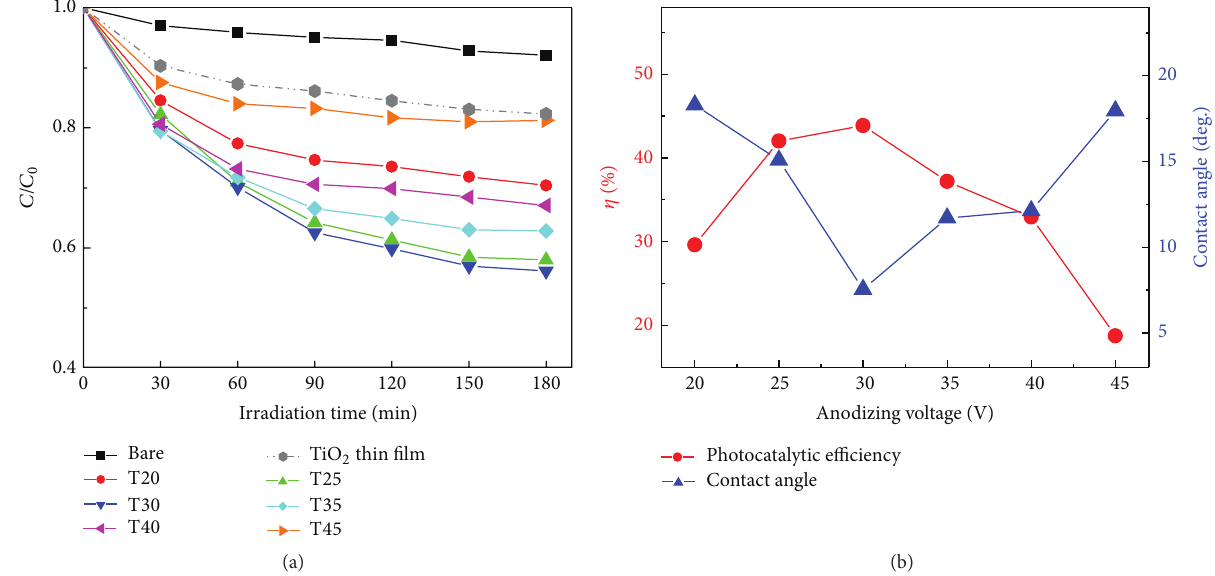
Figure 5: (a) Variations of methylene blue concentration with UV irradiation time for the samples. (b) Photocatalytic efficiency and water contact angle of TNA film as a function of anodizing voltage.